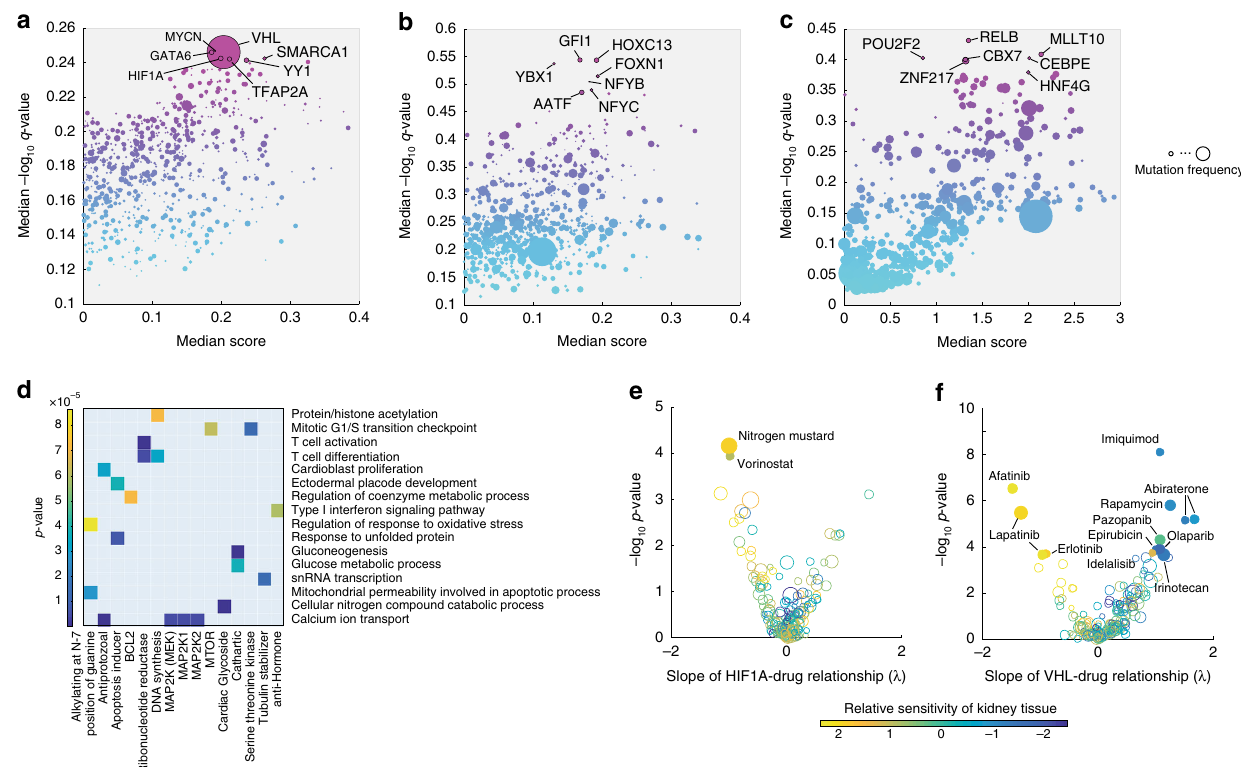
Fig. 4 Inferring TRs as mediators of in vivo metabolic changes. a – c Prediction results in three previously published data sets comprising metabolic pro fi les of tumor vs. proximal healthy tissue from 21, 138, and 10 patients with clear-cell renal cell carcinoma 7 ( a ), lung cancer 43 ( b ), and colon cancer 12 ( c ). Each dot represents the strength ( x -axis, median score) and signi fi cance ( y -axis, q -value, corrected for multiple tests, blue to purple color range) of a TR in mediating in vivo metabolic changes. Dot-size indicates the frequency of mutations in the TR-encoding gene for the respective cancer type, derived from the Catalog of Somatic Mutations In Cancer (COSMIC) 38 . Gene-name labels are shown for the top 1% most signi fi cant hits (see Supplementary Discussion and Supplementary Fig. 7). d 131 clusters of functionally related TRs (Supplementary Data 3) were tested against 82 different drug modes of action (MoA) to fi nd a signi fi cant over-representation of drug-TR associations. Colored squares indicate the signi fi cance of the enrichment analysis. Only TR clusters and drug MoAs with at least one signi fi cant association ( p -value < 1e − 4, Bonferroni-adjusted threshold) are shown in the heatmap. e , f Each dot represents one of the tested FDA-approved drugs. Estimated in fl uence of changes in TR activity on drug susceptibility (i.e., λ ) and corresponding p -value signi fi cance are reported. Dot size is proportional to the number of TRs that exhibit a signi fi cant association (linear regression p -value ≤ 2.67e − 4,